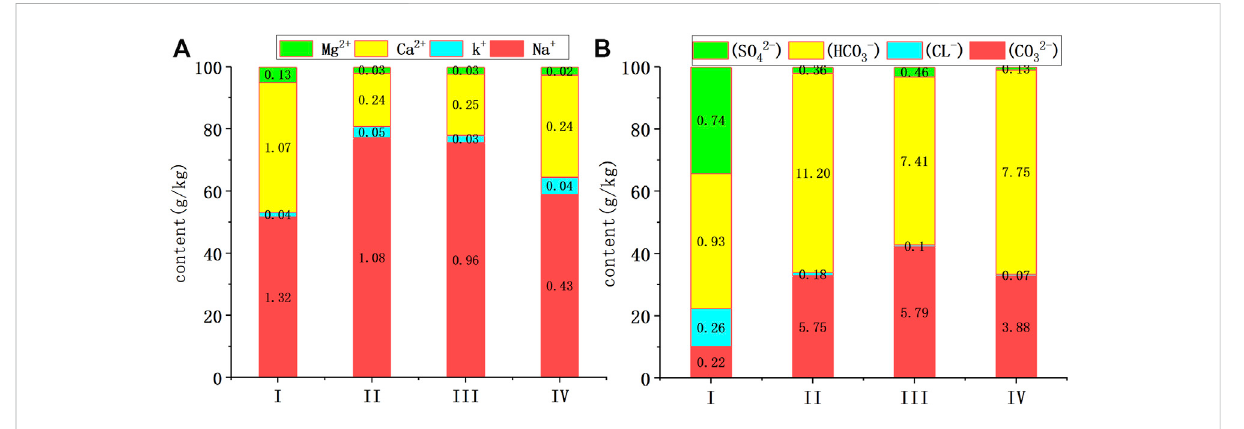
FIGURE 4 Ion composition and structure of salt meadow soil on lake